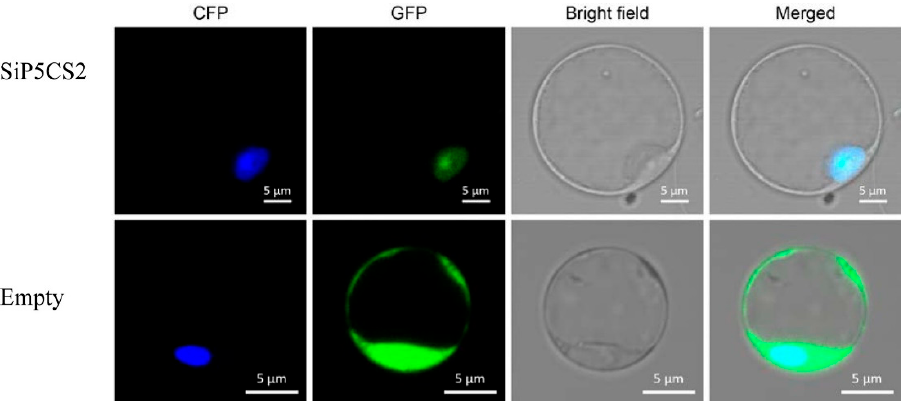
Figure 11. Subcellular localization of SiP5CS2. SiP5CS2 is localized to the nucleus. The SiP5CS-GFP construct and the empty vector (GFP, green fluorescent protein) were co-transformed into Arabidopsis protoplasts with the pAN580-ECFP-Ghd7 vector (a nuclear marker). The fluorescent signal of SiP5CS-GFP (green, pseudo-color) was specifically detected in the nucleus and exclusively co-localized with pAN580-ECFP-Ghd7 (yellow). The free GFP signal was observed in both the nucleus and cytoplasm.